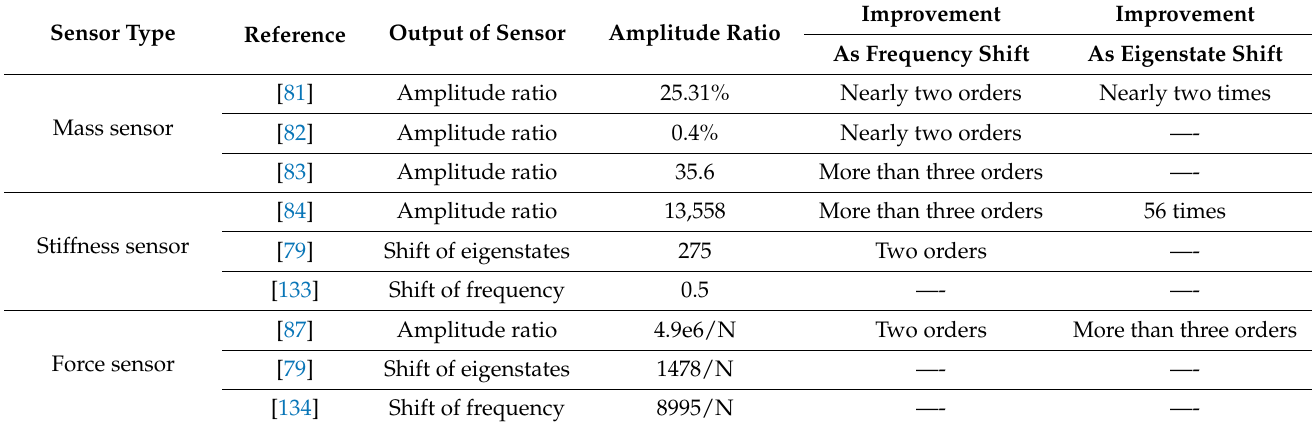
Table 4. Comparisons of EL-SCRB sensors for stiffness and force